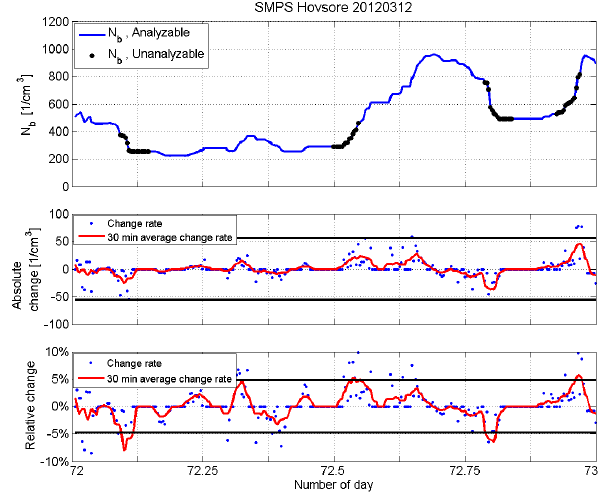
Figure 6. Uppermost graph: Background particle number concen- tration ( N b ) as function of time during 12 March 2012 with ana- lyzable and unanalyzable time periods marked separately. Middle graph: Absolute change rate of N b from individual data points and as 30min sliding average. The black lines are the threshold val- ues for marking a time period unanalyzable ( ± 56cm − 3 ) . Bottom graph: Same as middle graph but for relative change rate. Here the threshold values are ± 5%.